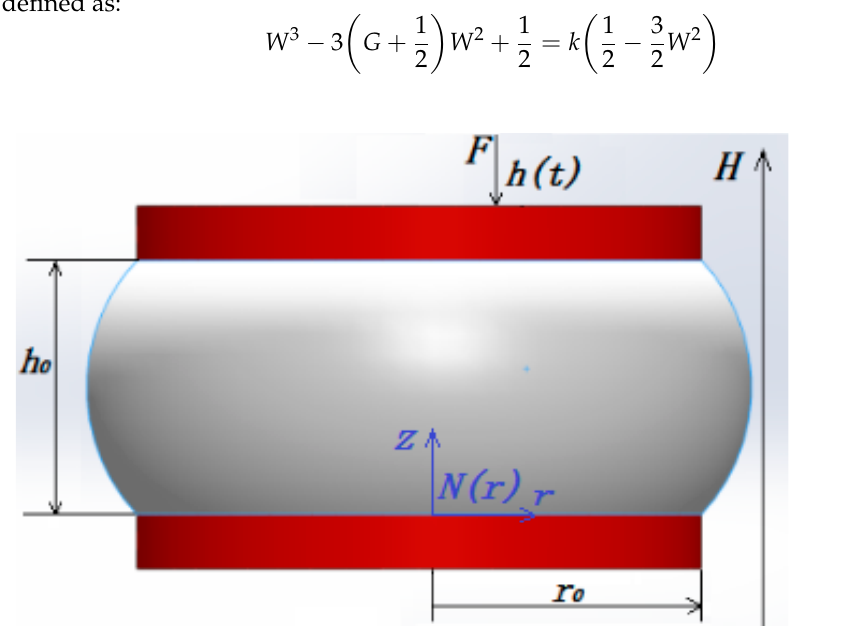
Figure 2. The sketch of the compression of MR fluids between two parallel plates.